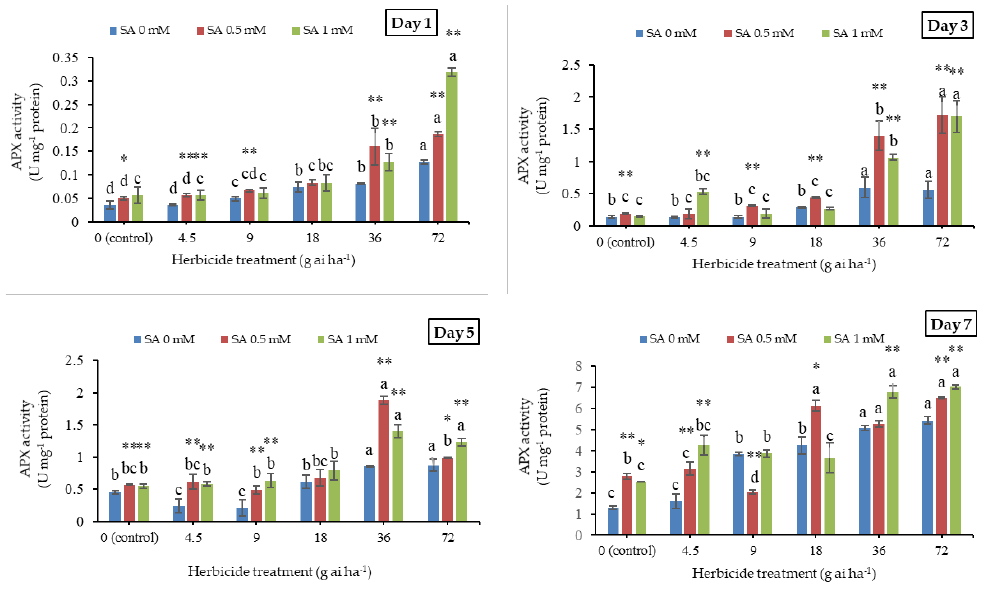
Figure 4. Changes in ascorbate peroxidase (APX) activity in the leaf tissues of wheat at 1, 3, 5, and 7 days after herbicide application at different rates. The leaves were pre-treated with different concentration of salicylic acid (SA) 3 days prior to herbicide application. The bars represent the treatment mean ± SD ( n = 4), and the bars with different lower-case letters were significantly ( p ≤ 0.05) different, according to the Duncan’s test. Asterisks indicate significant difference between the herbicide only and herbicide with each concentration of SA, according to the Independent Samples t - test.